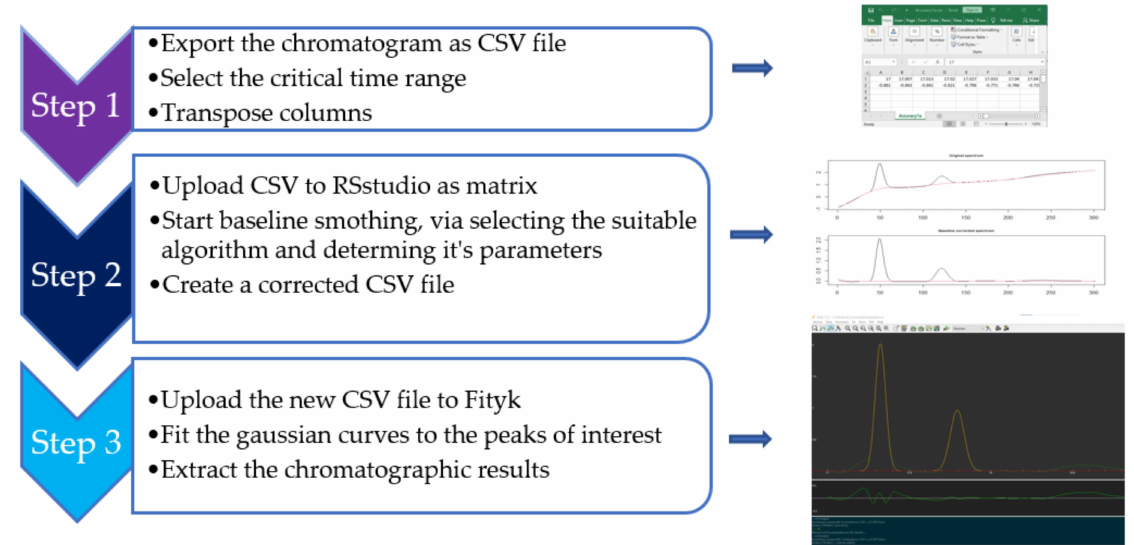
Figure 2. Schematic presentation of the procedure of baseline correction.